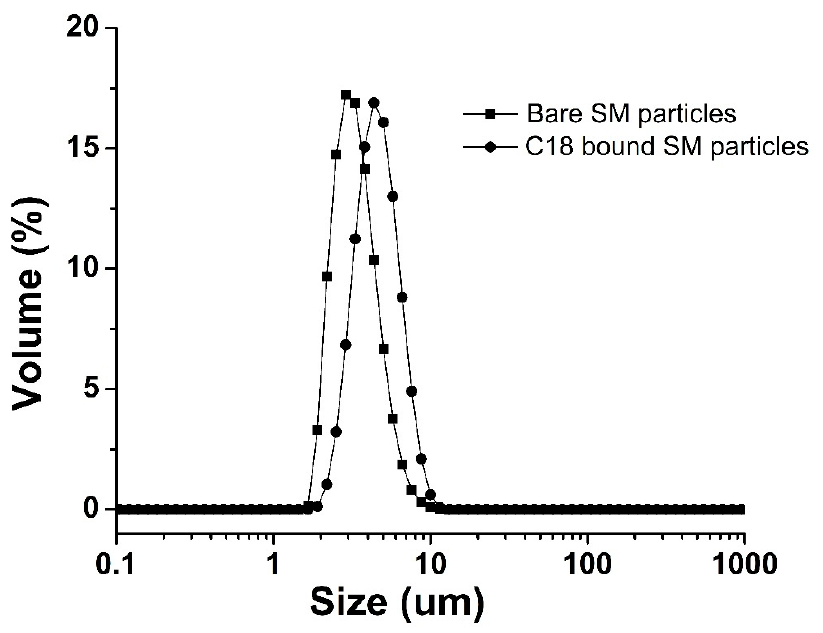
Figure 2. PSD of bare and C18-bound SM particles. Table 1. Particle-size distributions of bare and C18-modified silica monolith particles. Bare Silica Monolith Particles